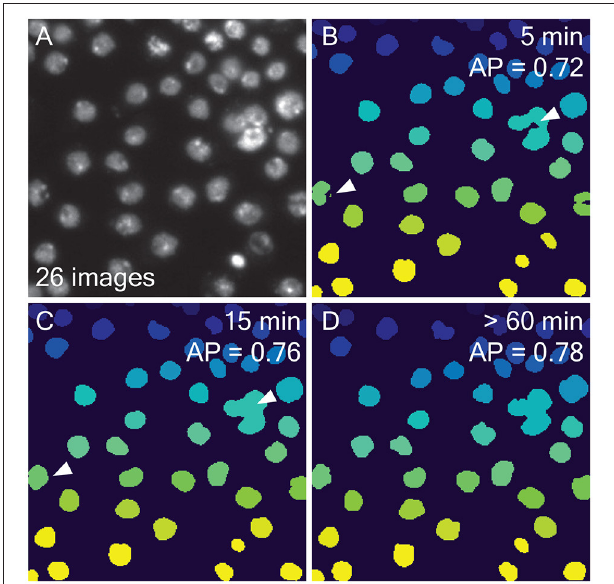
FIGURE 4 | Comparing automatic and manual ground-truth generation with LABKIT : (A) Fluorescence image of nuclei (out of 26 images) extracted from the 2018 Data Science Bowl (Caicedo et al., 2019). (B) Results from LABKIT automated segmentation of (A) after extracting connected components and giving each instance a unique pixel value. The arrows point to various segmentation errors. On the top right corner, the total time necessary to obtain the corresponding segmentation of all 26 images (including labeling) is indicated. Below the timing is the average precision (see Methods) as compared to a dense manual labeling performed by another observer. (C) Curation of (B) with same post-processing. The arrows point to the corrected errors mentioned in (B) . The timing information includes (B) . (D) Dense manual labeling of (A) and the same post-processing as in (B) . No scale bar was available for the